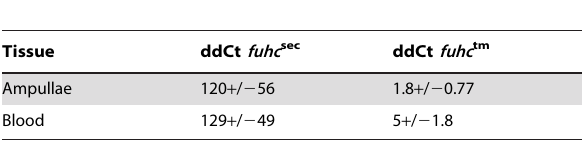
Table 1. qPCR expression levels of the fuhc in ampullae and